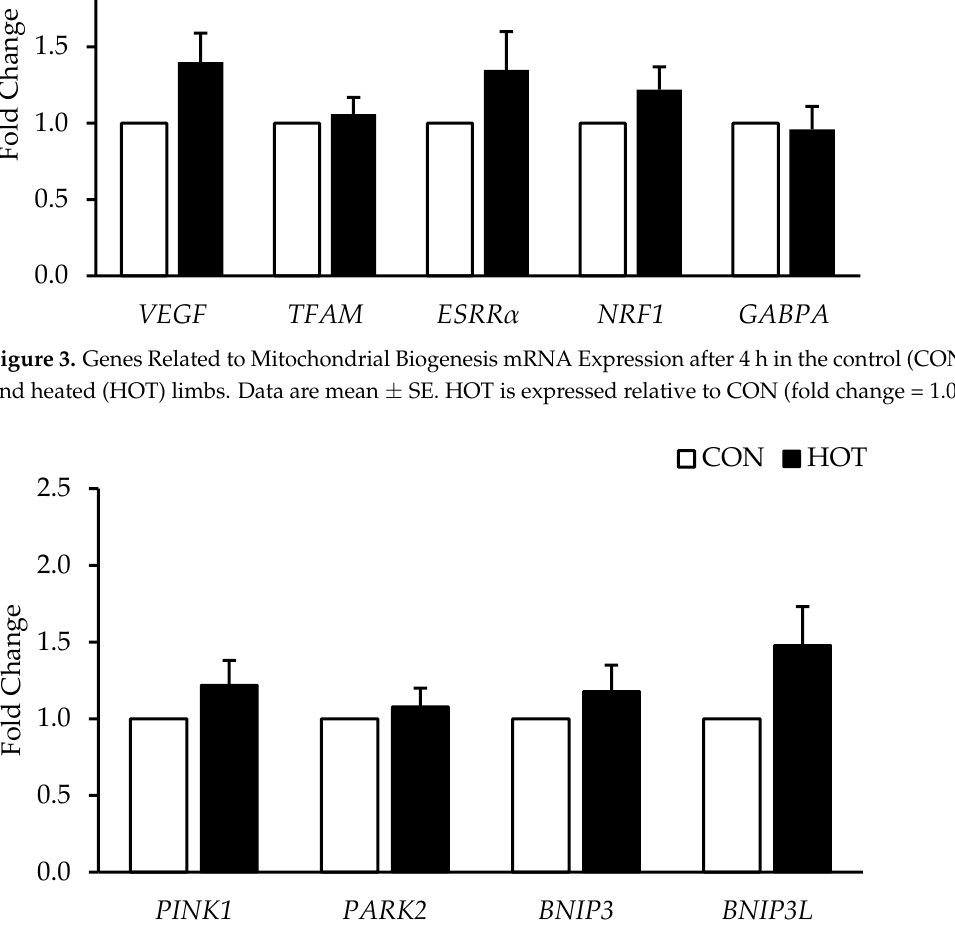
Figure 4. Genes Related to Mitophagy mRNA Expression after 4 h in the control (CON) and heated